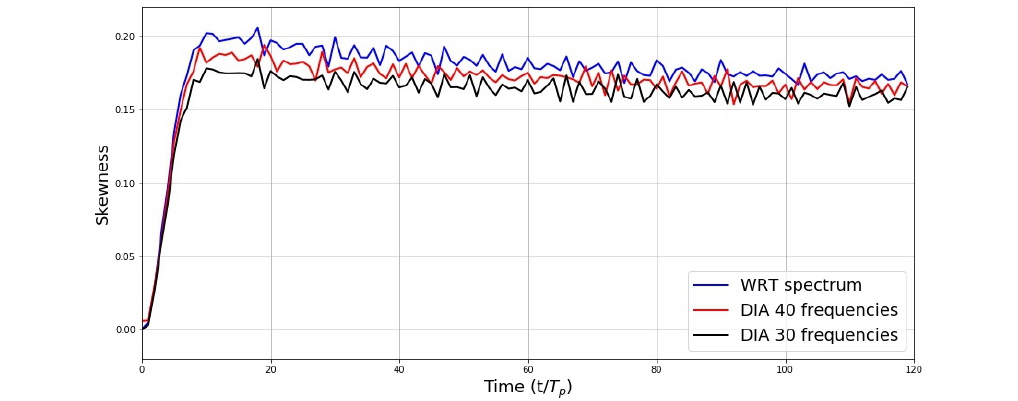
Figure 7. Same as Figure 6 with the use of the weak energy